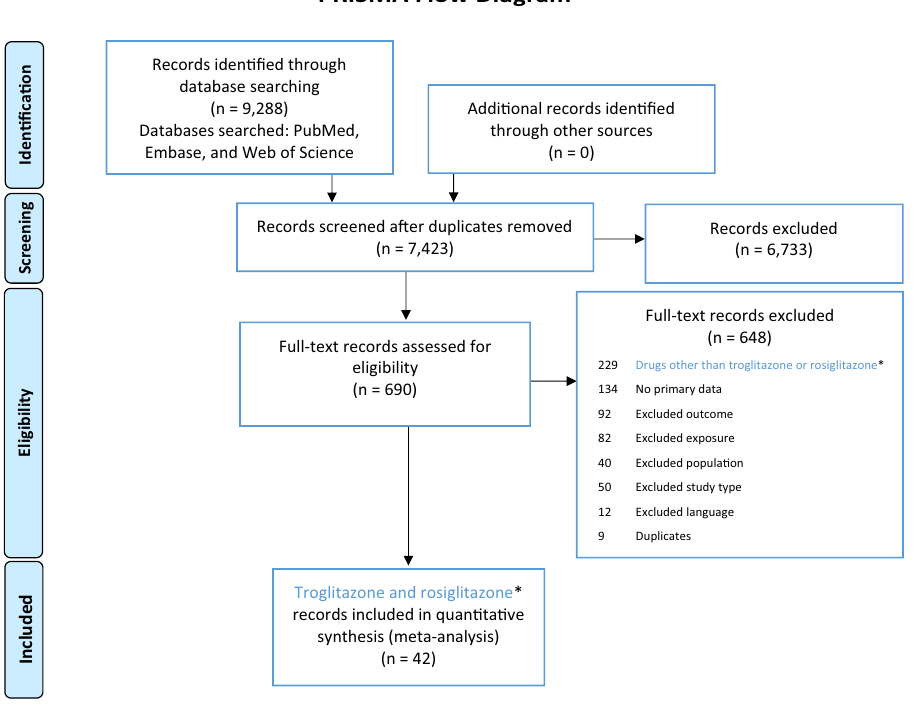
Figure 1. PRISMA flow diagram depicting study inclusion and exclusion justification. *Results on drugs other than troglitazone and rosiglitazone will be published in forthcoming